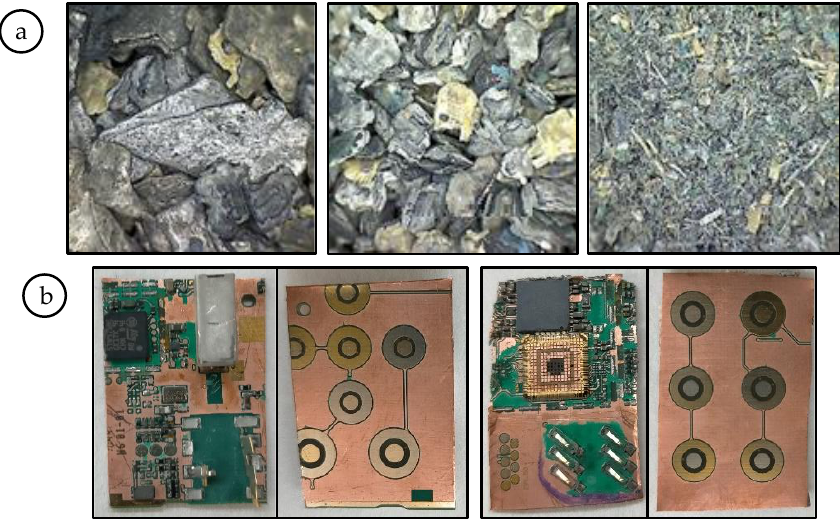
Figure 2. ( a ) Pulverized PCB sample according to particle size (>1.25 mm, 1.25 – 0.75 mm and <0.75 mm) (1:30 magnification) and ( b ) entire PCB pieces (3.5 cm ± 0.6 cm × 2.1 cm ± 0.1 cm) after treatment with a 10 M NaOH solution.